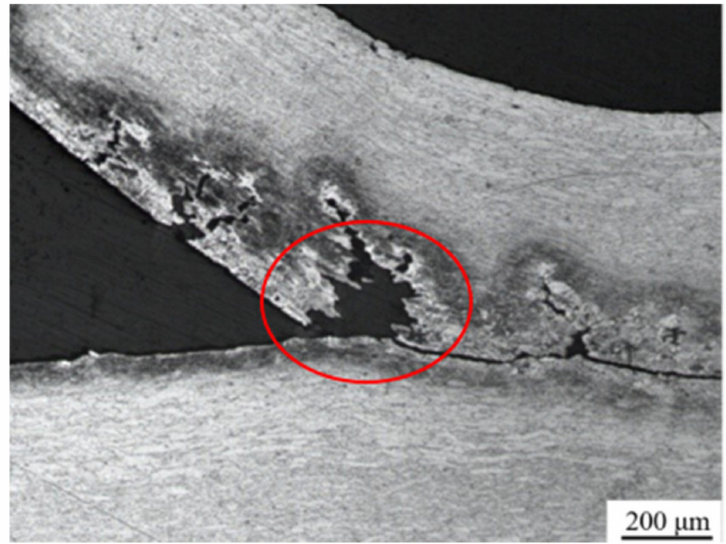
Figure 13. Tearing process on the inner surface near the round